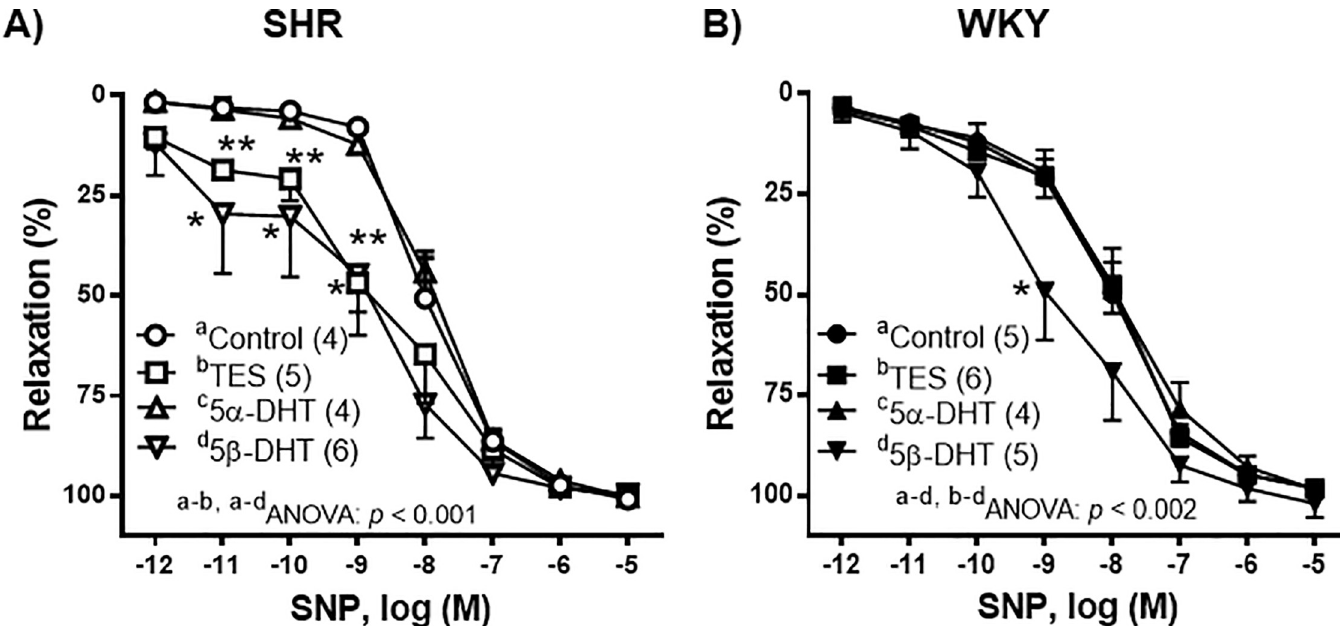
Fig 2. Effect of androgens on the vasodilator response to sodium nitroprusside (SNP). Effect of 10 nM testosterone (TES), 5 α -dihydrotestosterone (5 α -DHT) and 5 β - dihydrotestosterone (DHT) on the concentration-response curves to sodium nitroprusside (SNP) in the mesenteric arteries of hypertensive (SHR) and normotensive (WKY) rats. Results (mean ± SEM) are expressed as the percentage of the inhibition of the contraction induced by 1 μ M noradrenaline. � p < 0.01, �� p < 0.001 compare to control condition (vehicle group). Number of animals used, n = 4–6.